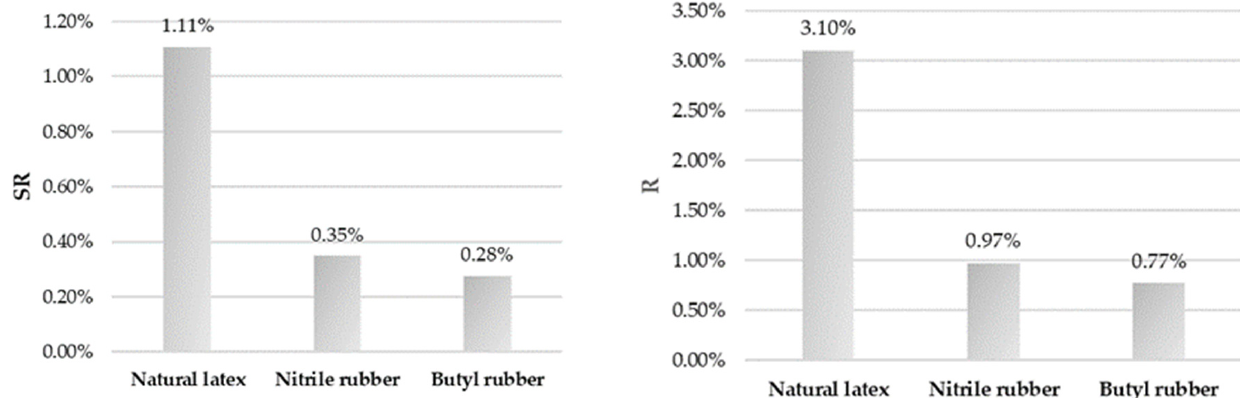
Figure 3. Uncertainty budget for the reproducibility of the performed measurements (on the left) and the reproducibility limits (on the right).